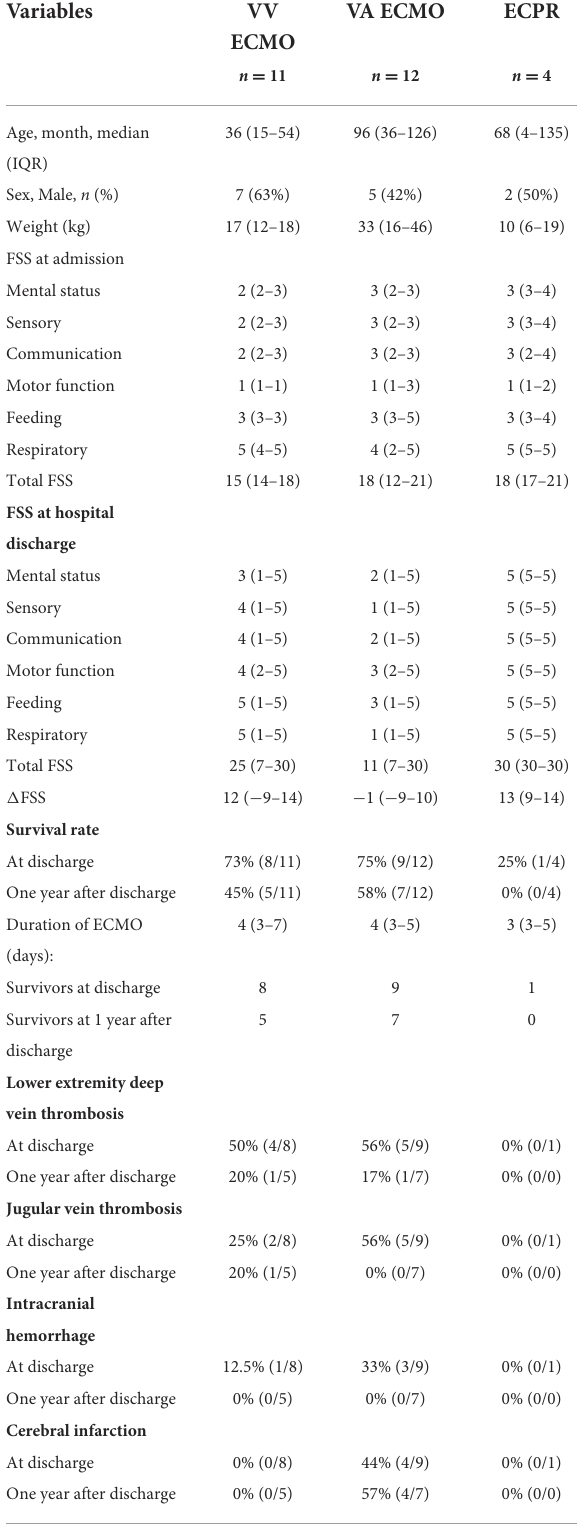
TABLE 2 Functional Status Scale for VV ECMO, VA ECMO and ECPR